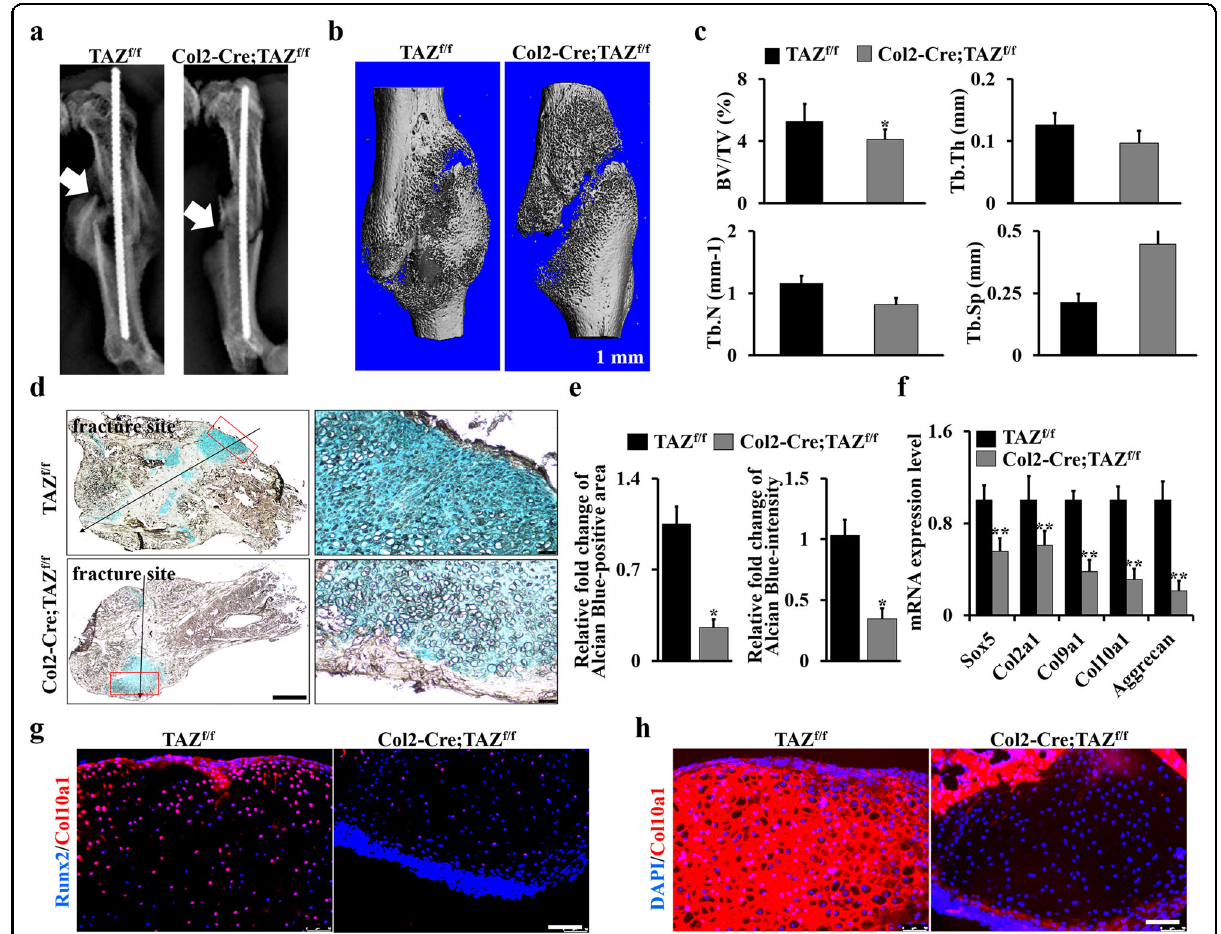
Fig. 7 Deletion of TAZ in chondrocytes impaired the fracture healing. a Representative X-ray images of the fractured femora of 3-month-old Col2-Cre;TAZ f/f mice and controls after 2-week fracture injury on the left hindlimbs. The white arrows point to the fracture site. n = 5 mice per group. b Representative micro-CT reconstructions of the callus tissues at the fracture sites after 2-week surgery ( n = 5 mice per group). Scale bars, 1 mm. c Histomorphometric analysis of bone parameters from b . Bone volume fraction (BV/TV); trabecular thickness (Tb.Th); trabecular number (Tb.N); trabecular spacing (Tb.Sp). d Representative Alcian blue staining image of the fracture calluses after 2-week injury. Scale bars, 1000 μ m (left panel); 50 μ m (right panel). e Alcian blue-positive area and intensity were quanti fi ed by ImageJ software based on Alcian blue staining in d . f Gene expression analysis of the chondrocyte markers using tissues isolated from fracture callus. g , h Immuno fl uorescence staining analysis for Col10a1 and Runx2 in fracture callus tissues from Col2-Cre;TAZ f/f mice and controls. Scale bars, 50 μ m. The experiment was independently repeated for three times. Error bars were the means ± SEM of triplicates from a representative experiment. * P < 0.05, ** P <